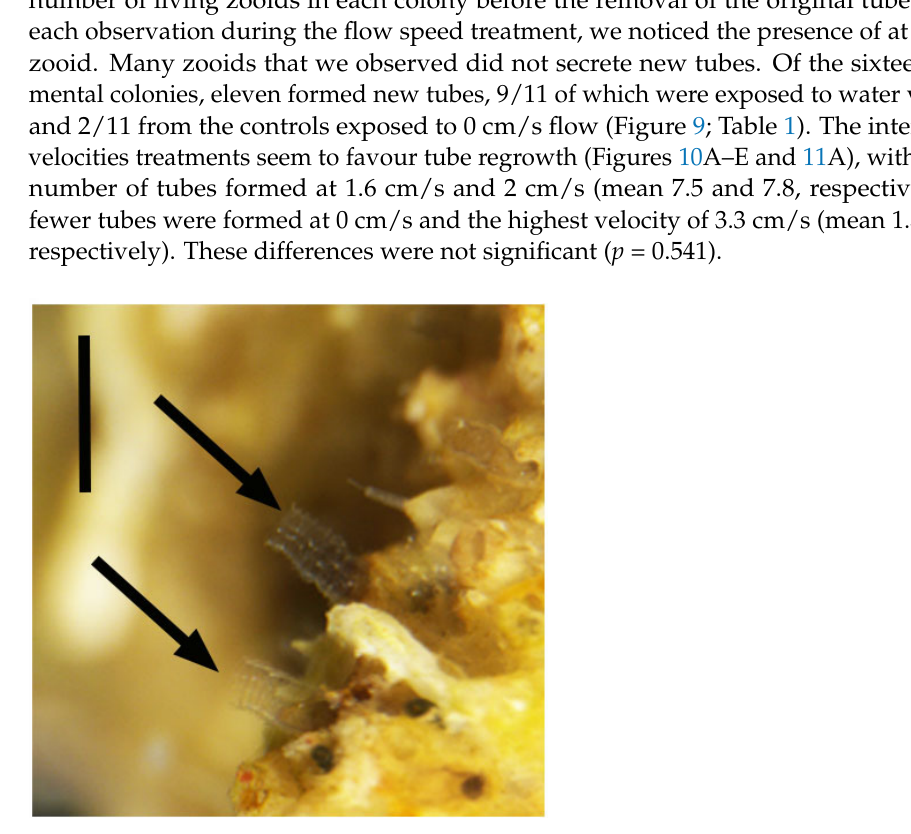
Figure 9. Experimental zooids and colony. Two new tubes are indicated by arrows. Scale bar 800 µm.